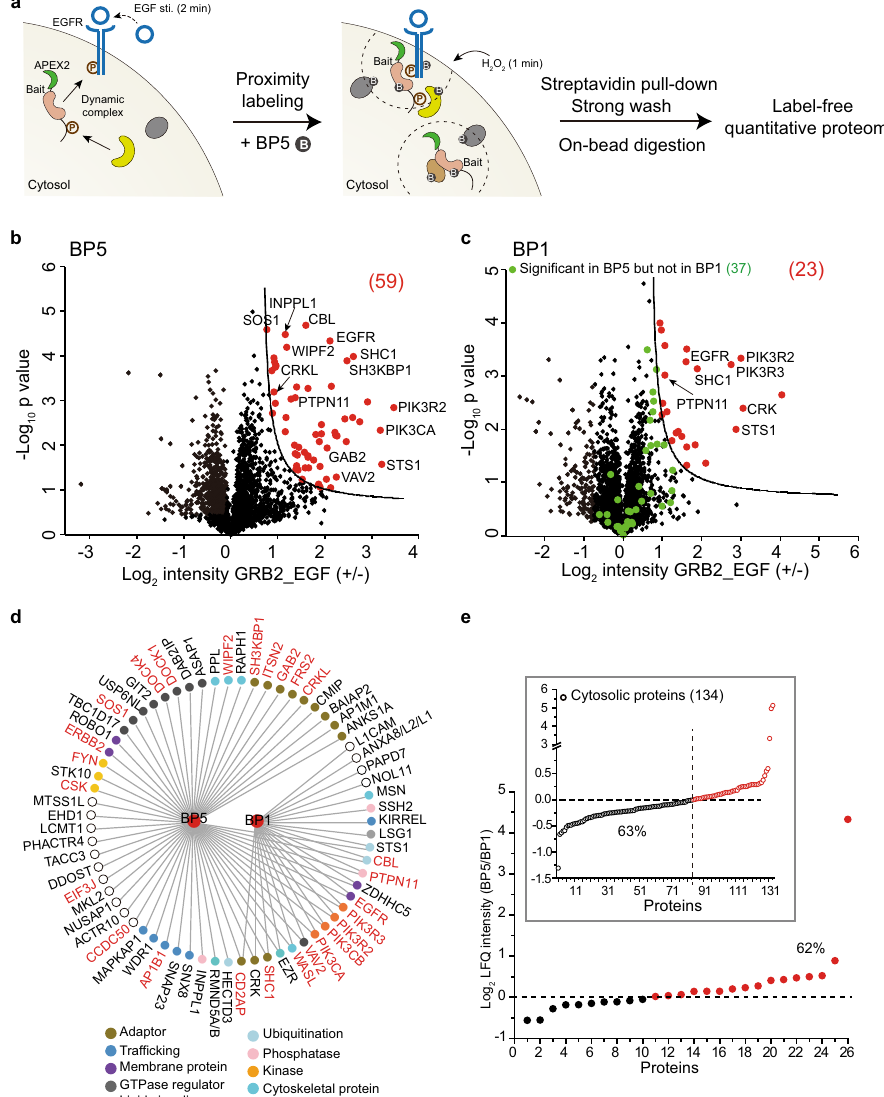
Fig. 2 Development of a highly selective proximity proteomics approach for temporal membrane-associated and cytosolic interactome. a Scheme of BP5-based proximity proteomic analysis of adapter protein interactome upon EGF stimulation in living cells. b , c Volcano plots of GRB2-interacting proteins in HeLa cells with stably expressed APEX2-FLAG-GRB2 quanti fi ed by BP5- and BP1-based proximity proteomics ( n = 3 independent biological experiments). Signi fi cantly changed proteins upon 2 min EGF stimulation are highlighted in red (FDR < 0.05 and S0 = 0.5). Relevant proteins that are signi fi cant in BP5 experiment but not in BP1 experiment are marked in green. d Interaction map and function annotation of signi fi cant GRB2-associated proteins identi fi ed by BP5- and BP1-proximity proteomics. The colored circles indicate the functional classi fi cation. Known GRB2- associated proteins were labeled in red. e Comparison of BP5 and BP1 labeling selectivity as indicated by both known GRB2-associated proteins and cytosolic proteins with GO annotation of cytosol identi fi ed from the same pull-down sample (insert). The average ratio of LFQ intensity (BP5/BP1) from three replicates were plotted. Source data are provided as a Source Data fi